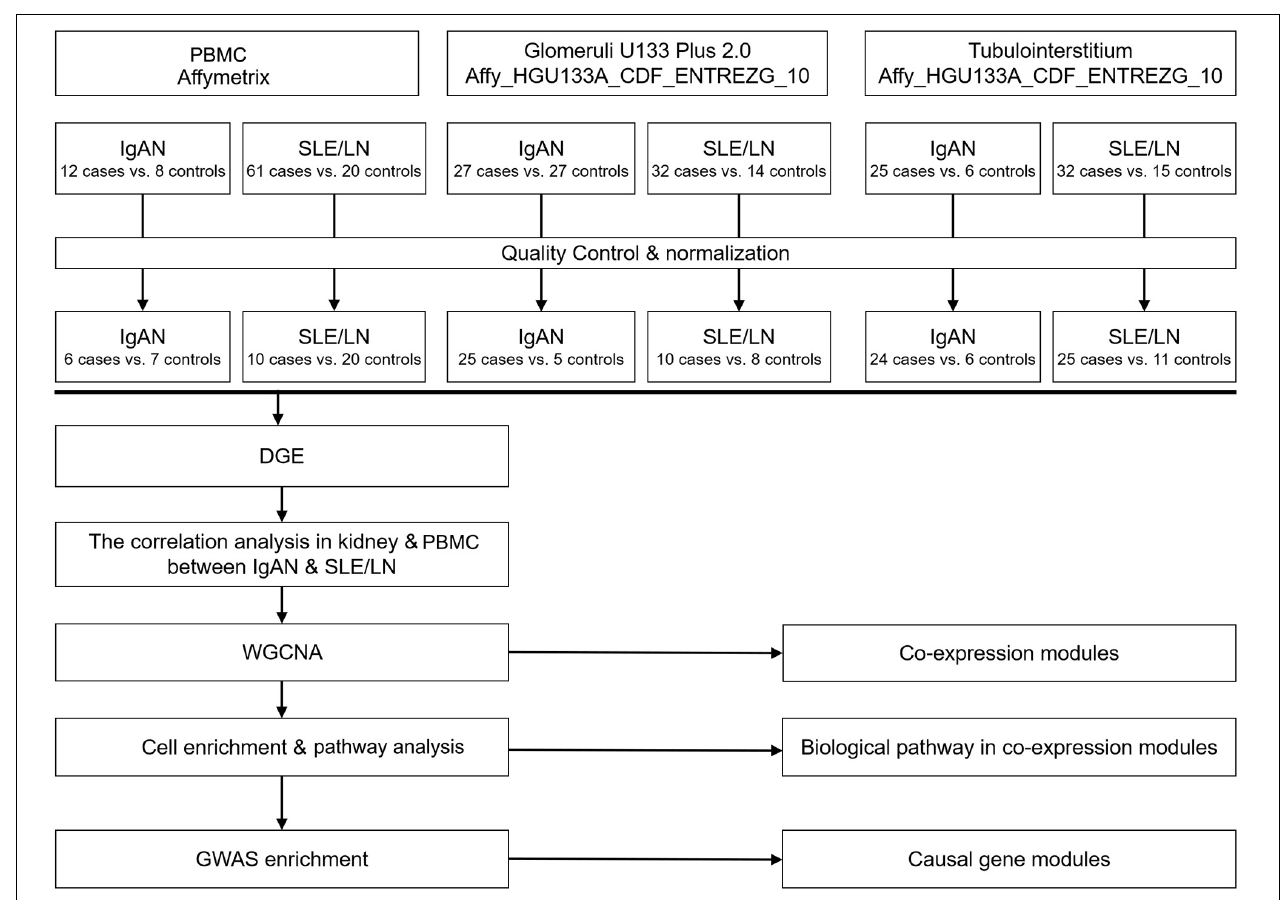
FIGURE 1 | Flow chart of the study design. First, the raw data were obtained from the GEO database and subjected to quality control and standardization. Second, the correlation between different genes and disease traits was analyzed. Then, WGCNA was used to identify gene modules co-associated with IgAN and LN glomeruli or renal tubules, and co-pathogenic pathways were identified through cell-specific enrichment analysis and GO pathway enrichment analysis. Finally, the causal gene modules were identified by GWAS enrichment analysis. GEO, Gene Expression Omnibus; WGCNA, weighted gene co-expression network analysis; IgAN, IgA nephropathy; LN, lupus nephritis; GO, gene ontology; GWAS, genome-wide association